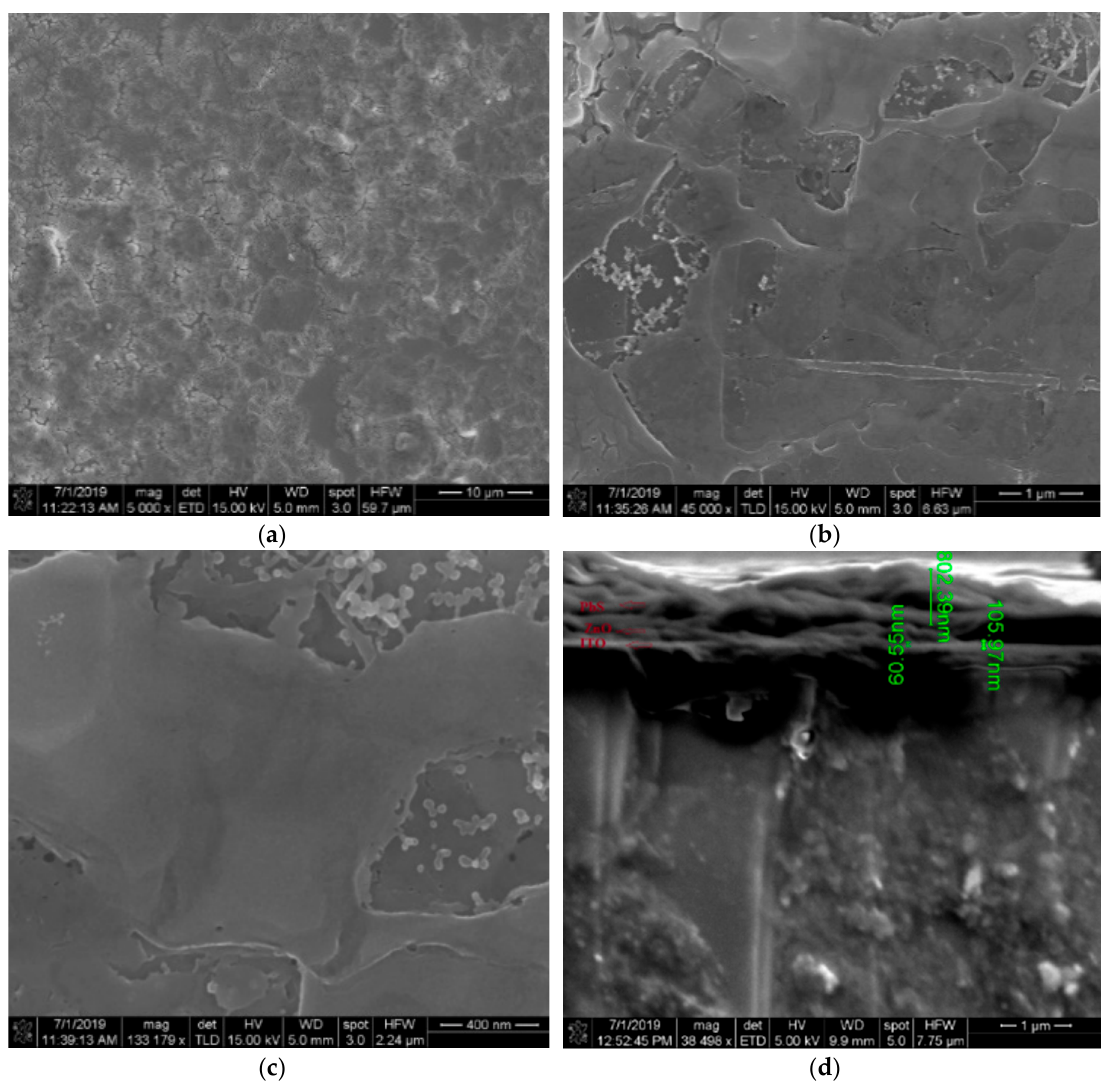
Figure 4. FESEM images of seven-layered TBAI and EDT exchanged film made using the spin coating method with different magnifications: ( a ) 10 μ m; ( b ) 1 μ m; ( c ) 400 nm. ( d ) Cross-sectional image of the sample made using the spin coating method.